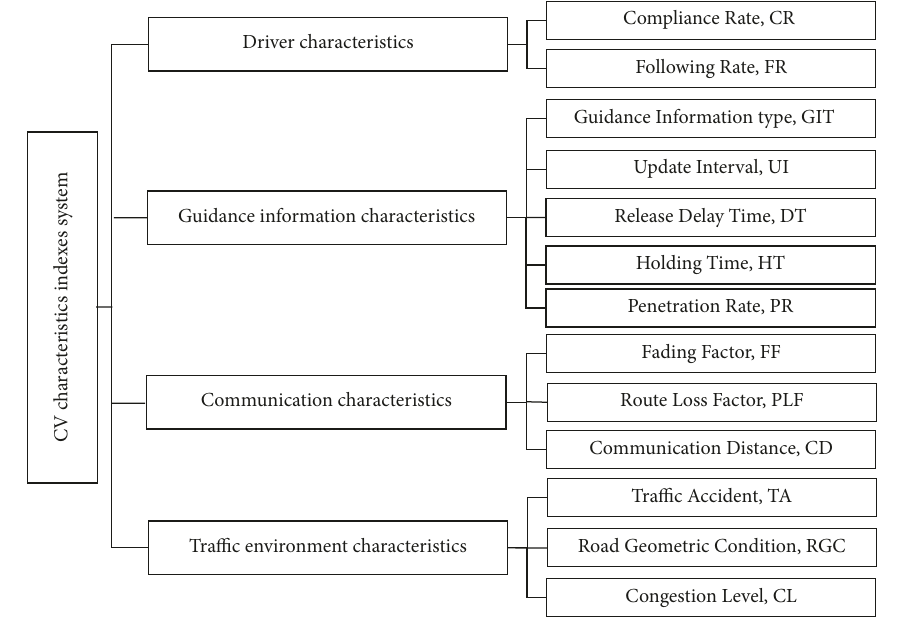
Figure 2: CV characteristics indexes